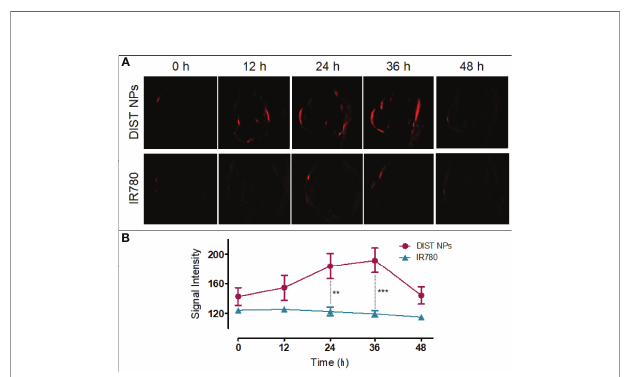
FIGURE 7 | The in vivo PAI results of the DIST NPs. The dynamic distributions of PA signal (A) and quantitative analysis of PA signal in the double-tumor mice (B) . The ** represents p < 0.01; and ***p <